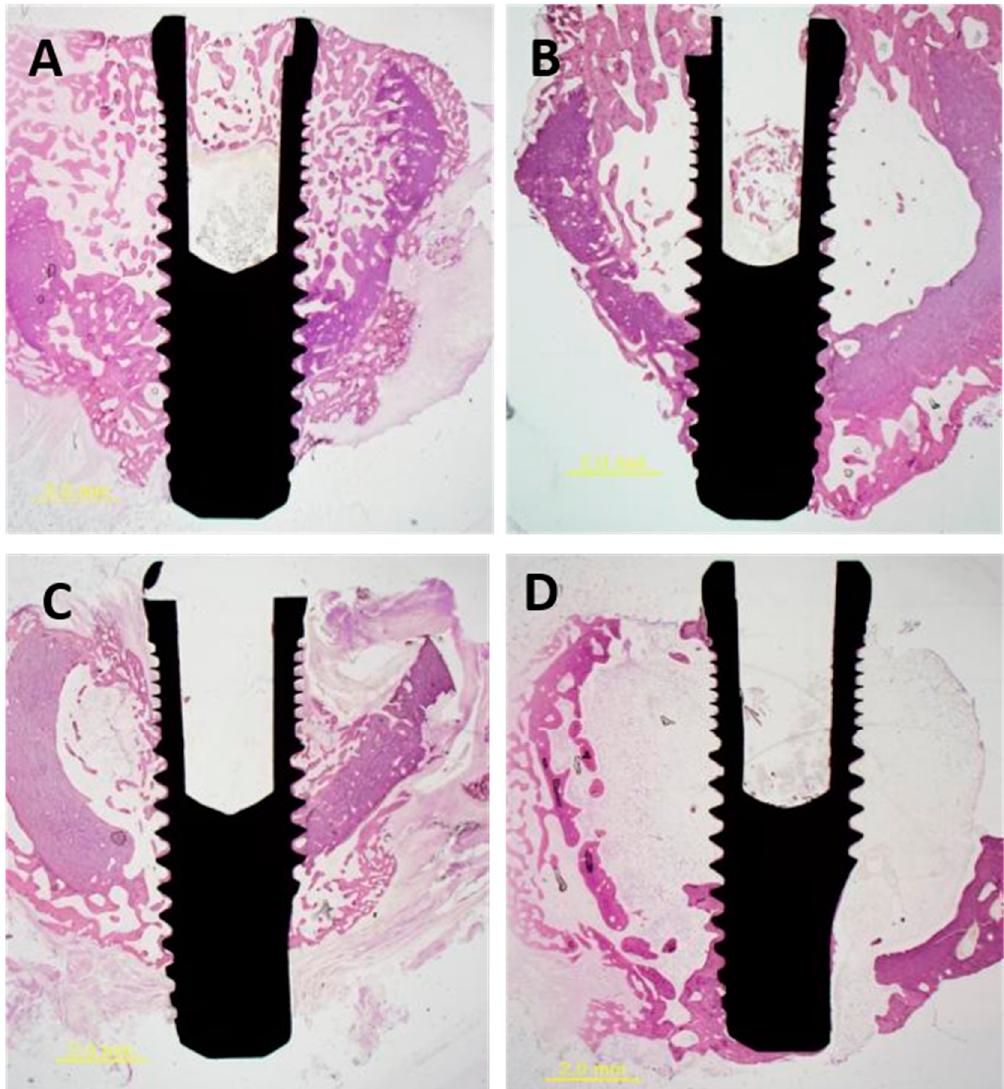
Figure 3. Histologic view at 8 weeks (original magnification 12.5×): ( A ) group 1; ( B ) group 2; ( C ) group 3; and ( D ) group 4.